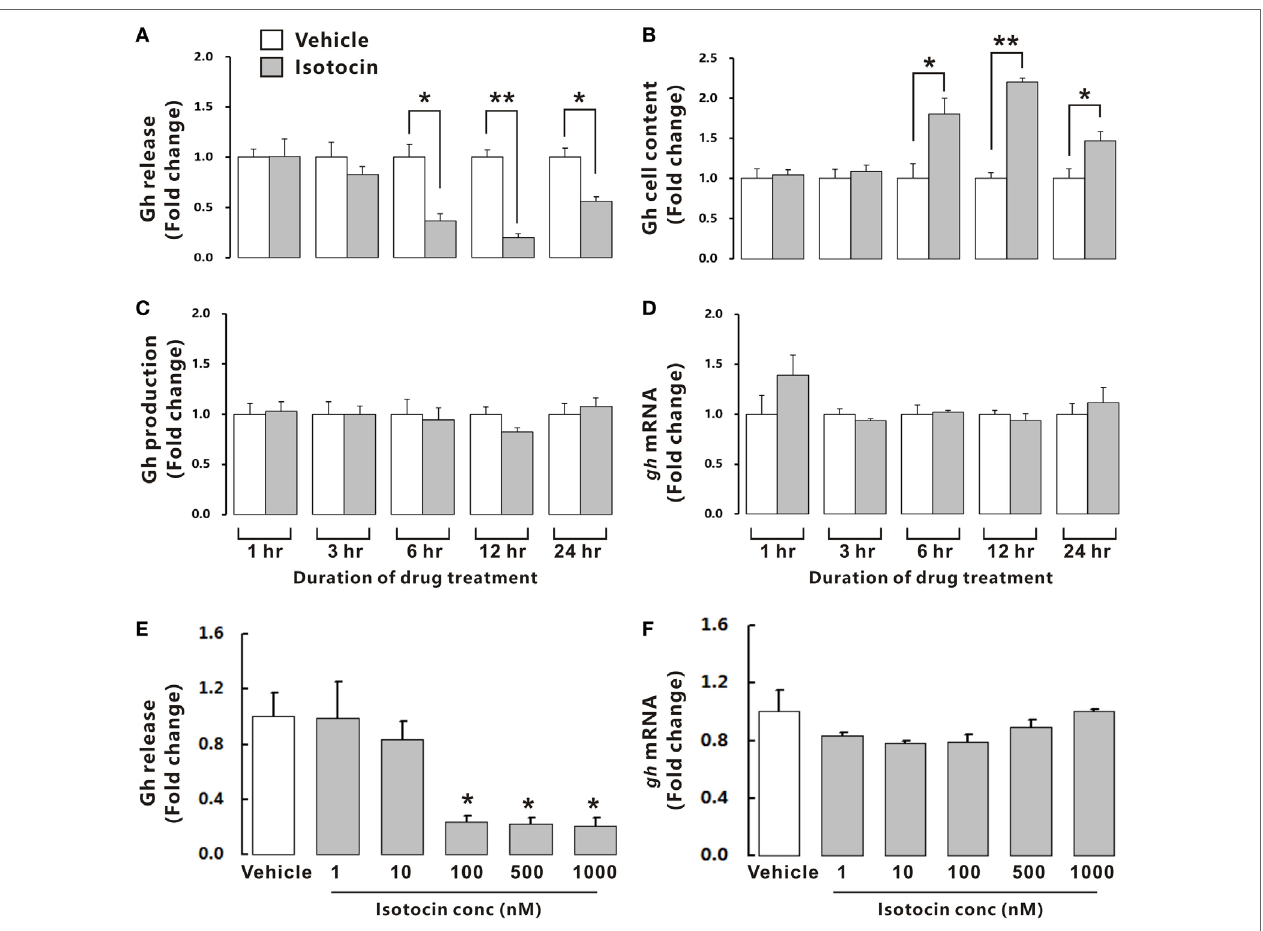
FigUre 7 | Effects of isotocin (Ist) on growth hormone (Gh) synthesis and release in primary pituitary cells of female ricefield eels. Time course of Ist (100 nM) on (a) Gh release, (B) cell content, (c) total production, and (D) gh mRNA in ricefield eel pituitary cells. (e,F) Dose-dependence of 12-h treatment with increasing levels of Ist (1–1,000 nM) on Gh release and gh mRNA, respectively. After drug treatment, culture medium was harvested for measurement of Gh release, and cell lysate was prepared for monitoring Gh contents in pituitary cells. In parallel experiments, total RNA was isolated for real-time PCR analysis of gh mRNA. Data were expressed as fold change relative to the corresponding vehicle control. Bars represent mean ± SEM of pooled results from four separate experiments ( n = 4). * P < 0.05; ** P < 0.01 between the indicated groups or vs. the vehicle control (e)